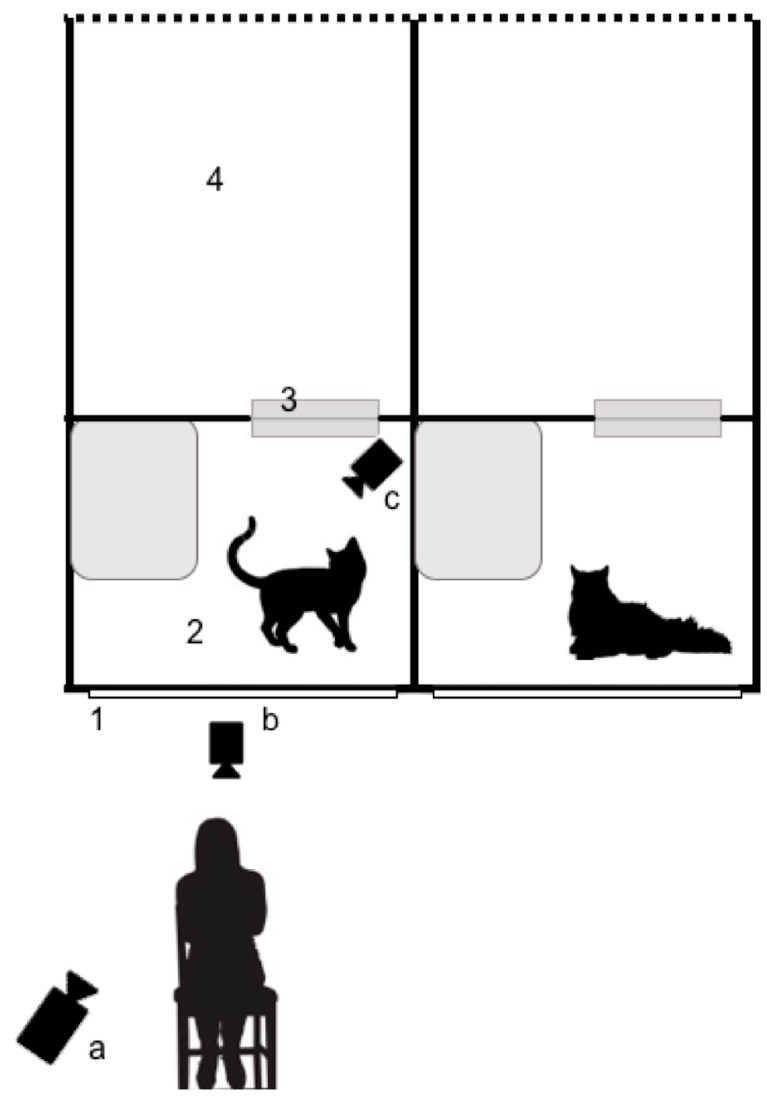
Figure 2. Experimental set-up (1 = pen door, 2 = indoor pen, 3 = cat flap, 4 = back enclosure; a = Panasonic HC-V270, b and c = GoPro HERO4).